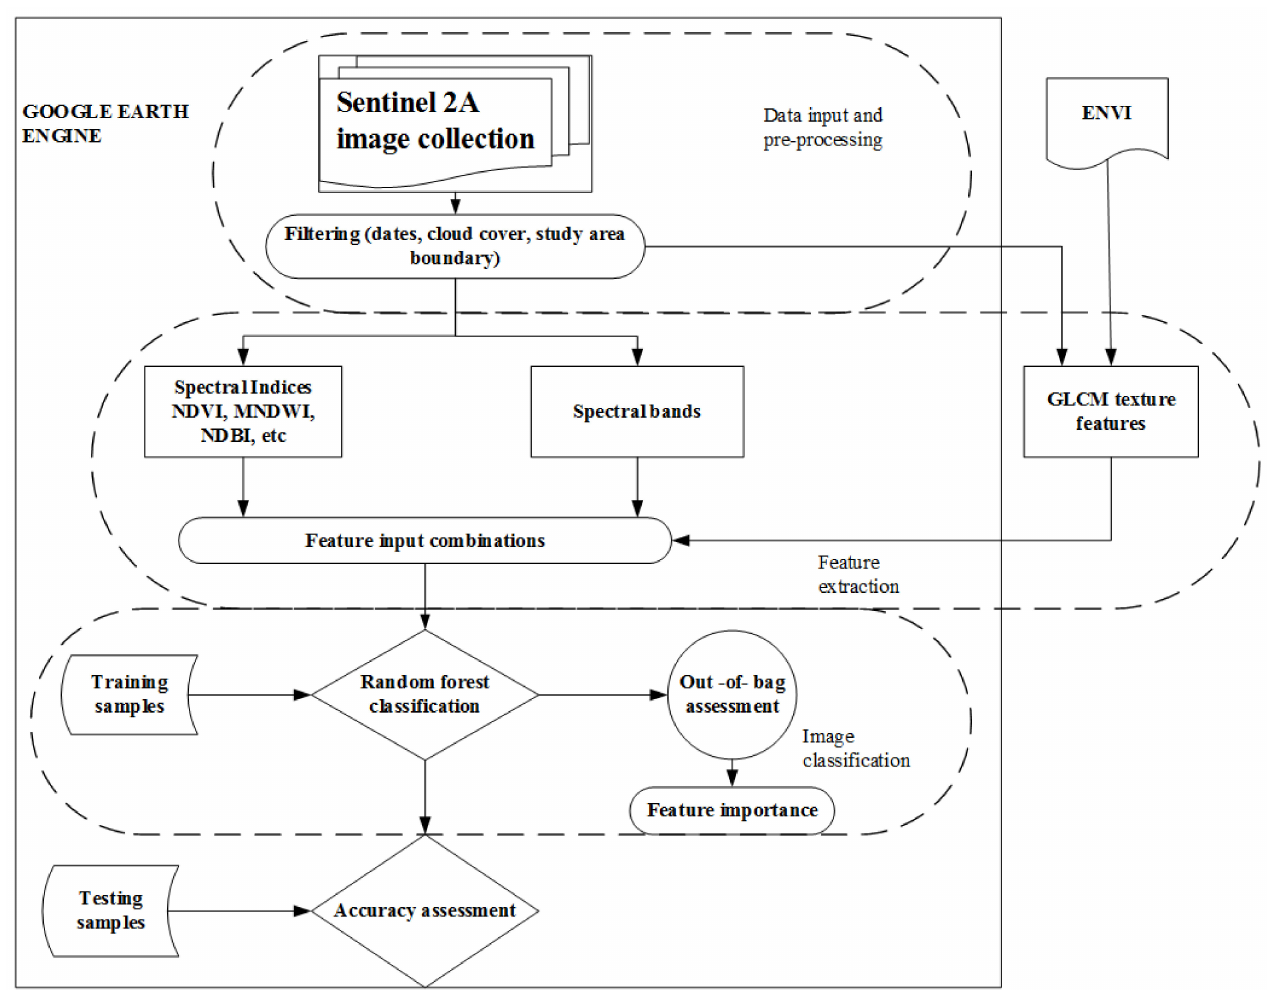
Figure 2. Research workflow chart.